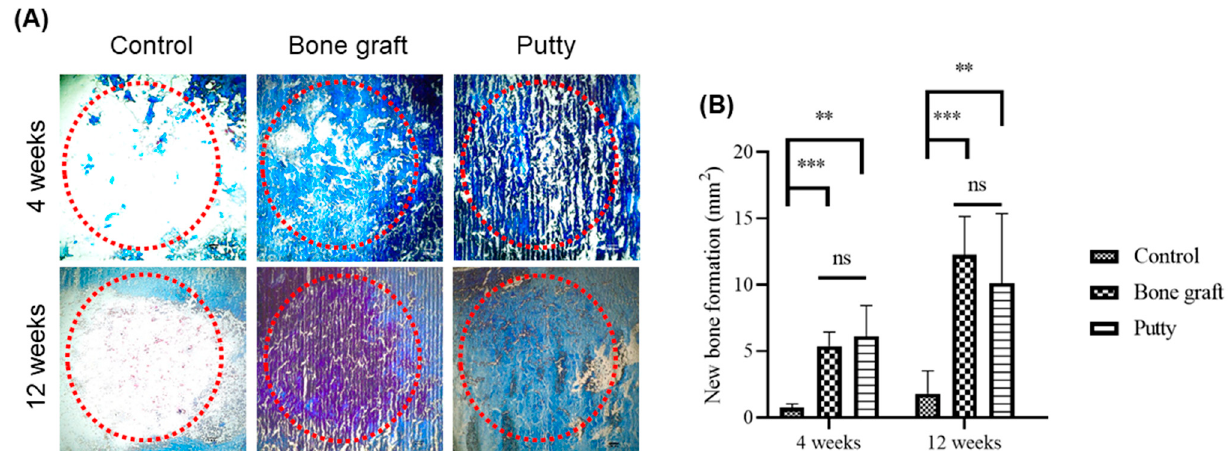
Figure 7. Masson trichrome staining histochemical examination of new bone collagen in the critical- sized bone defects. ( A ) Representative femoral sections were stained with Masson trichrome staining of the critical-sized bone defect. ( B ) Masson trichrome staining quantification of new bone formation in the bone graft and putty after implantation. The red dotted circle indicates the critical-sized bone defect. The significance was set at ns- ( p > 0.05), **—( p < 0.001), ***—( p < 0.0001). At 12 weeks, bone graft implanted defects a significant ( p < 0.0001) increase in the